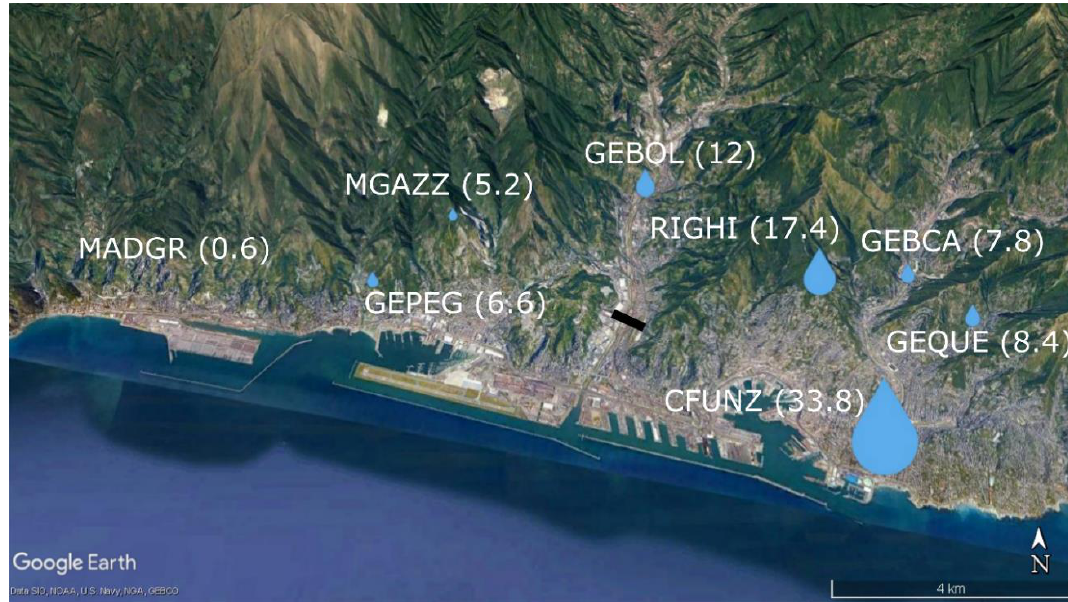
Figure 10. Accumulated surface precipitation between 09:00 and 10:00 UTC in Genoa. The accumulated precipitation at the CFUNZ station shown in mm h −1 and the size of other droplets scaled accordingly. Background map source: “© Google Earth”.